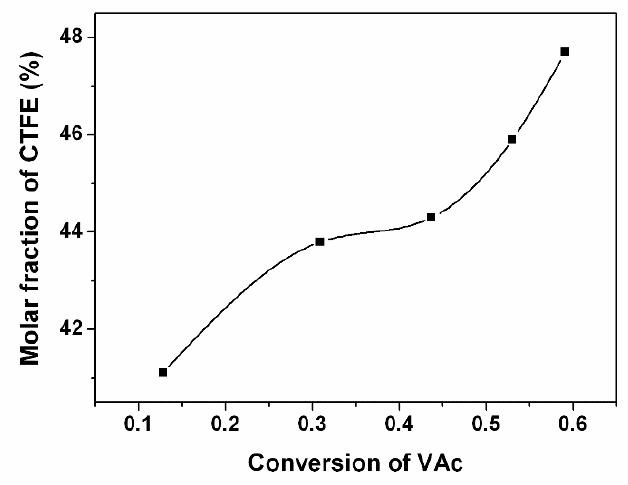
Figure 2. Molar content of CTFE in the copolymer as a function of VAc conversion (P4, P6, P7, P8, and P9).